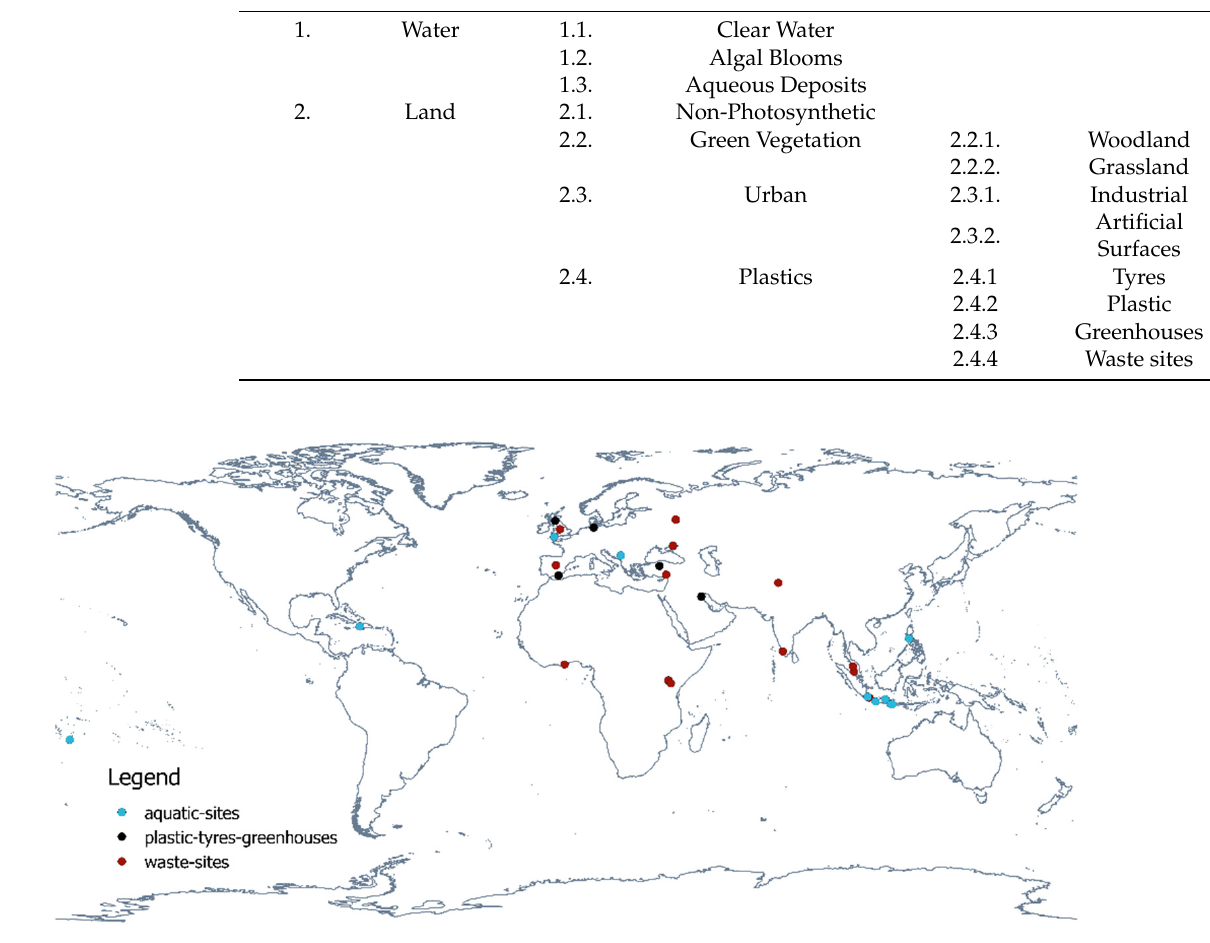
Figure 2. Locations and focus for the manually digitized training/validation dataset. For each target class, multiple homogeneous training pixels were taken across the different sites through the digitizing of polygons. Figure 3 shows the digitization for the Višegrad Dam aquatic site and tyre graveyard in Kuwait with the digitized pixels shown as crosses overlaid on the Sentinel-2 pseudo-true colour (left) and SAR backscatter image shown on the right. The fusion of Sentinel-1 and -2 for land cover mapping provides the land surface’s combined spectral and structural characteristics, with the results often having a higher accuracy than using either of the datasets individually [51]. For the Višegrad Dam, the SAR image shows that the floating mass has a higher backscatter than the water before the dam accumulation (top right), and similarly the tyre graveyard also shows higher backscatter for the filled tyre pits compared to the surrounding sand and empty pits (bottom